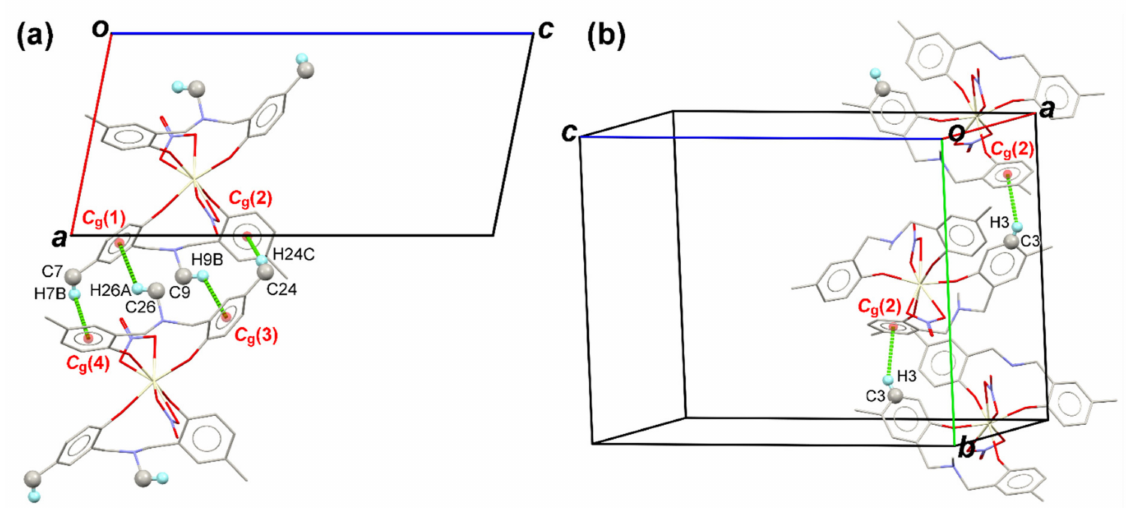
Figure 4. ( a ) A view down the [010] direction showing the part of the [100] molecular chain joined by several C methyl –H · · · π interactions, namely C26–H26A · · · C g (1), C24–H24C · · · C g (2), C9–H9B · · · C g (3), and C7–H7B · · · C g (4) contacts. ( b ) A view of a unit cell illustrating the part of the [010] molecular chain linked by the C3–H3 · · · C g (2) interactions. Note that the C g (1), C g (2), C g (3), and C g (4) are the centroids constructed from the atoms C1–C6, C11–C16, C18–C23, and C28–C33, respectively.